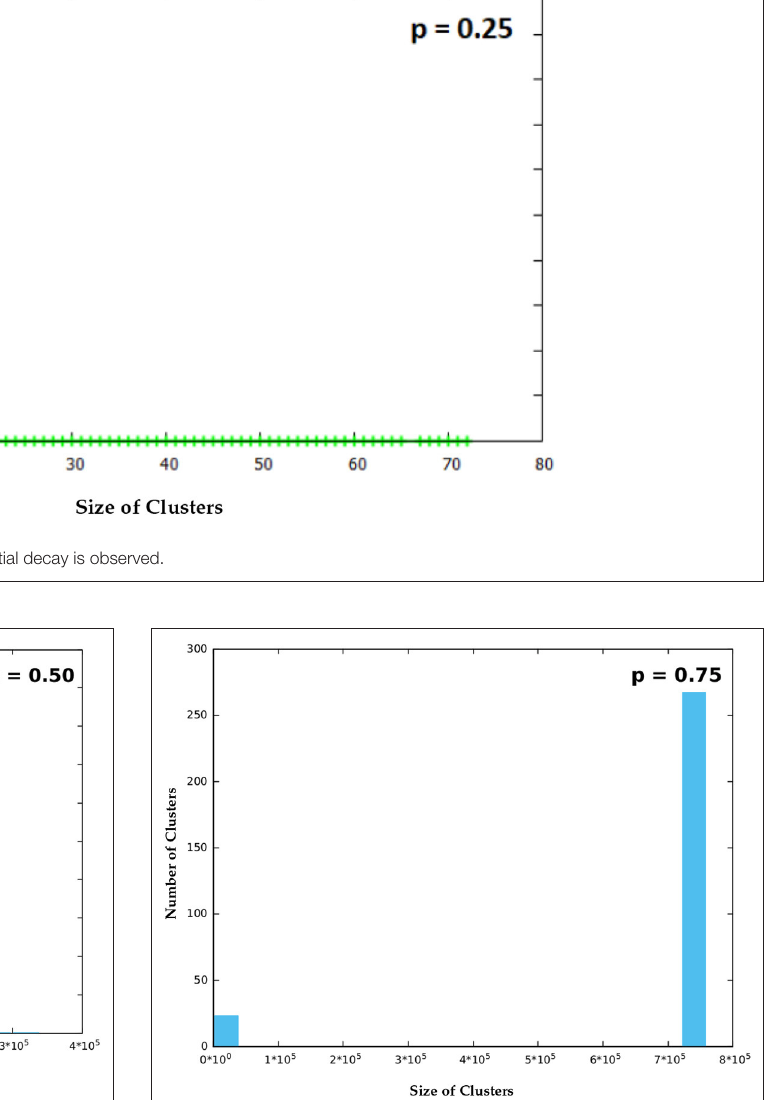
FIGURE 9 | In the super-critical phase when p = 0.75, only a single “large” cluster was seen for each one of the randomly generated binary matrices and a small number of irregularly distributed small